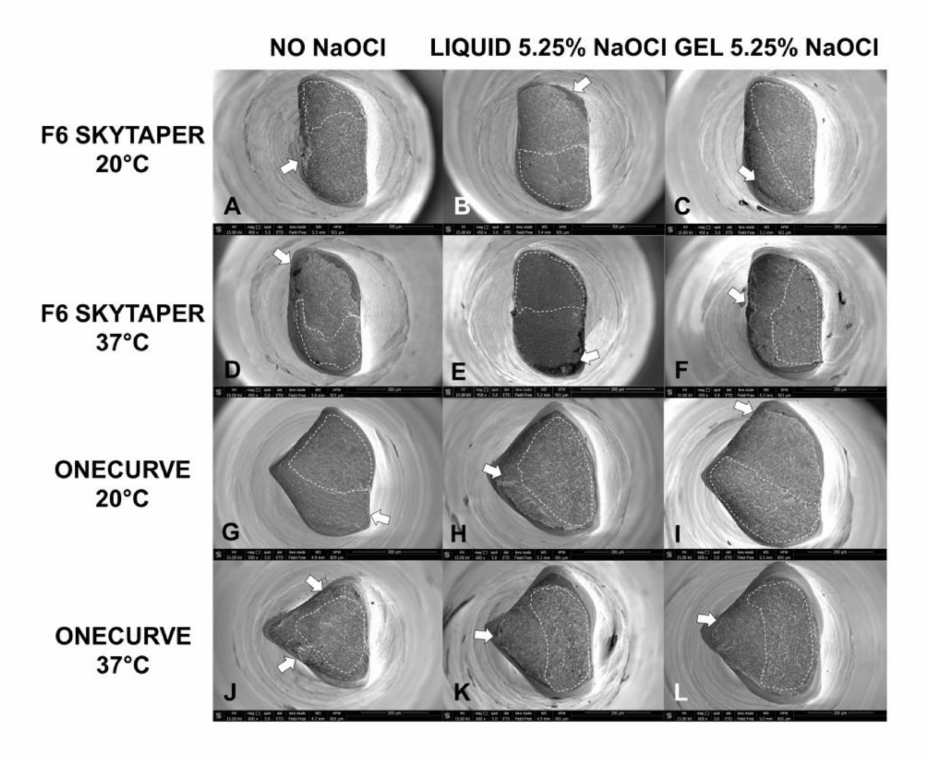
Figure 3. ( A – L ) Scanning electron micrographs of the fracture surface of F6 SkyTaper and OneCurve fragments in the axial view (450 × –600 × magnification) after the cyclic fatigue tests in the di ff erent experimental conditions. The white arrows indicate the origins of the crack, and the dotted area indicates the final abrupt breakage. The typical surface pattern of the fibrous fatigue zone showed dimples and cones in all of the fracture